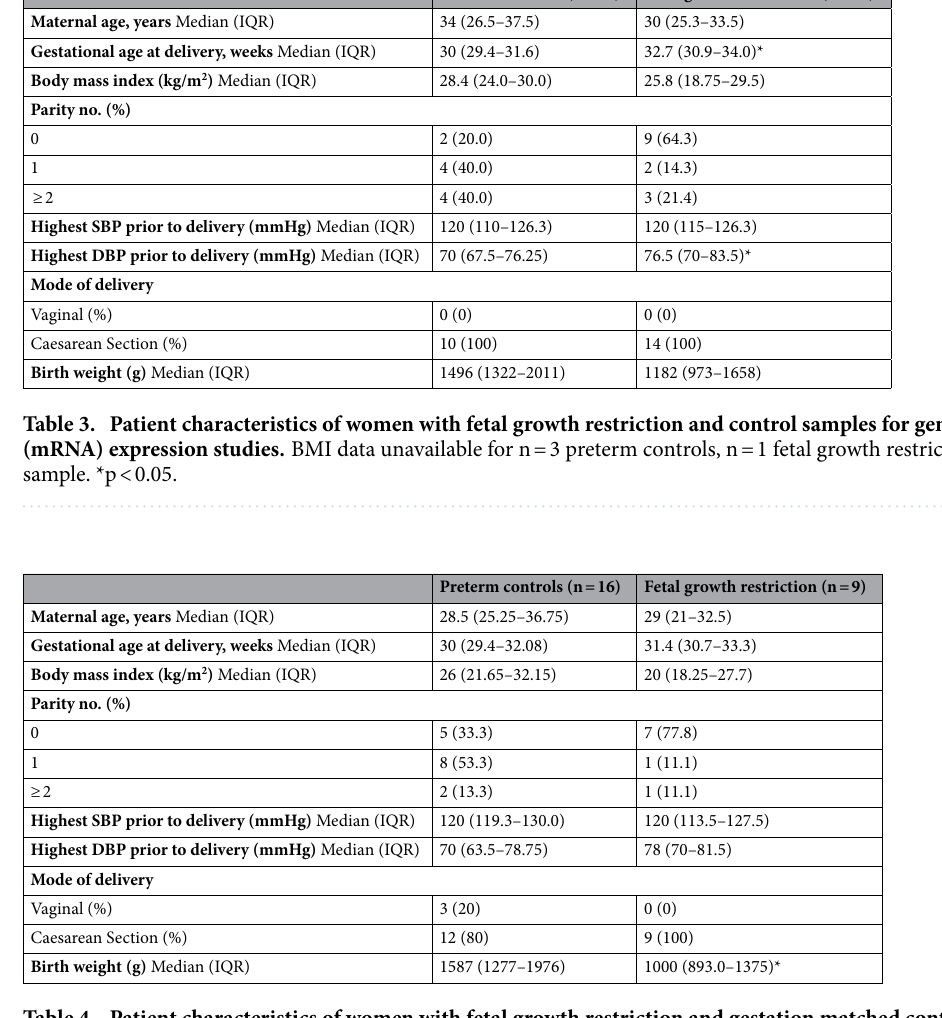
Table 4. Patient characteristics of women with fetal growth restriction and gestation matched control samples for protein studies. BMI data unavailable for n = 3 preterm control samples. *p < 0.05.